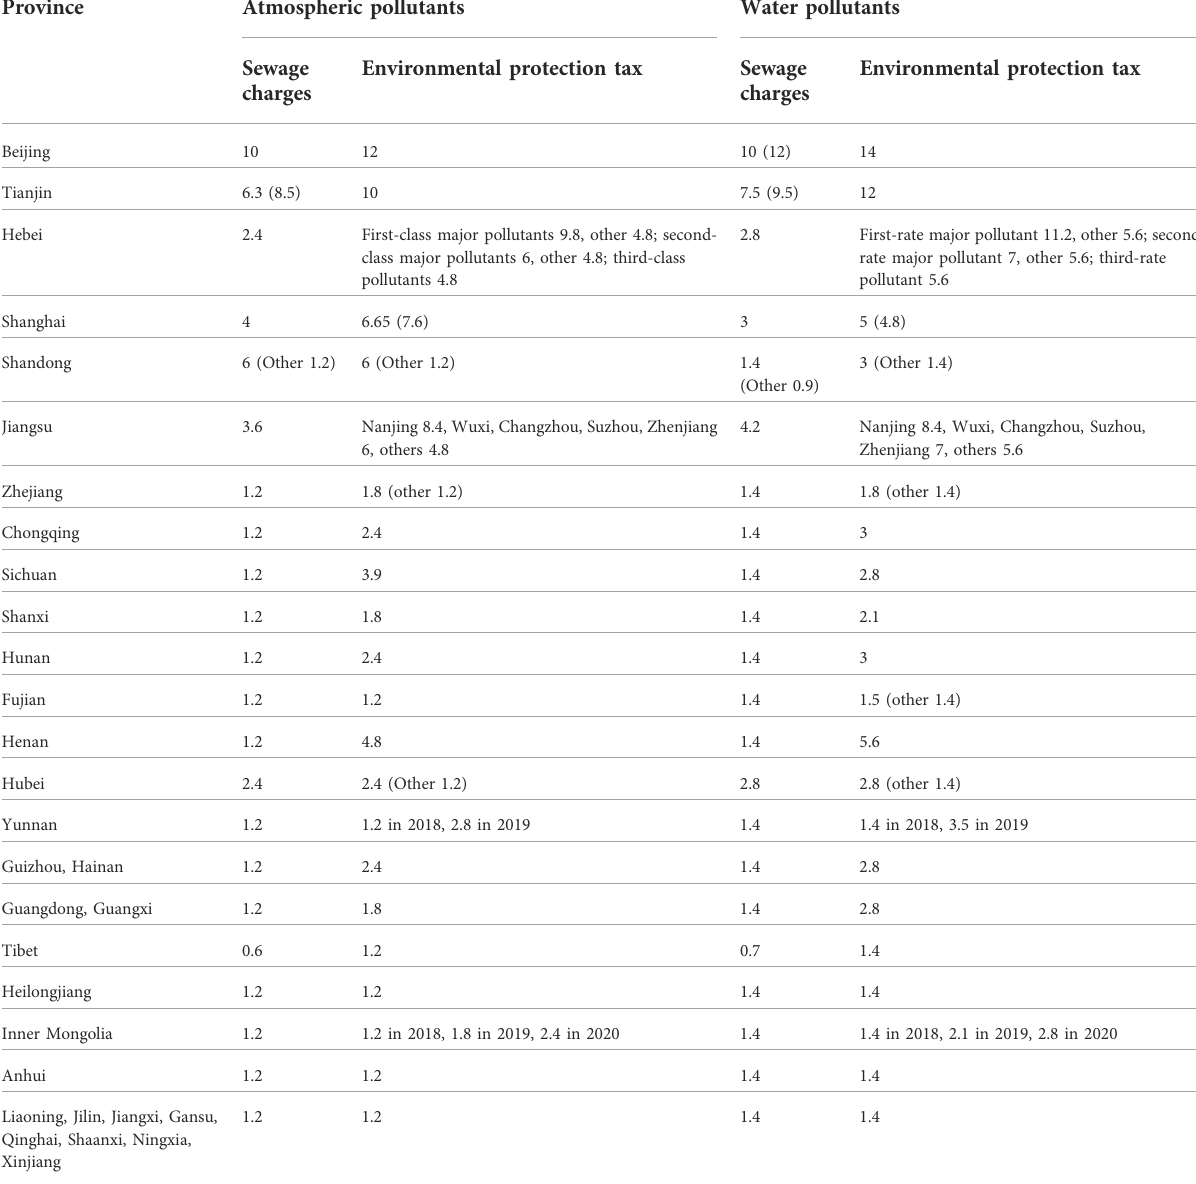
TABLE 1 Comparison of emission fees and 2018 environmental protection tax levy standards by